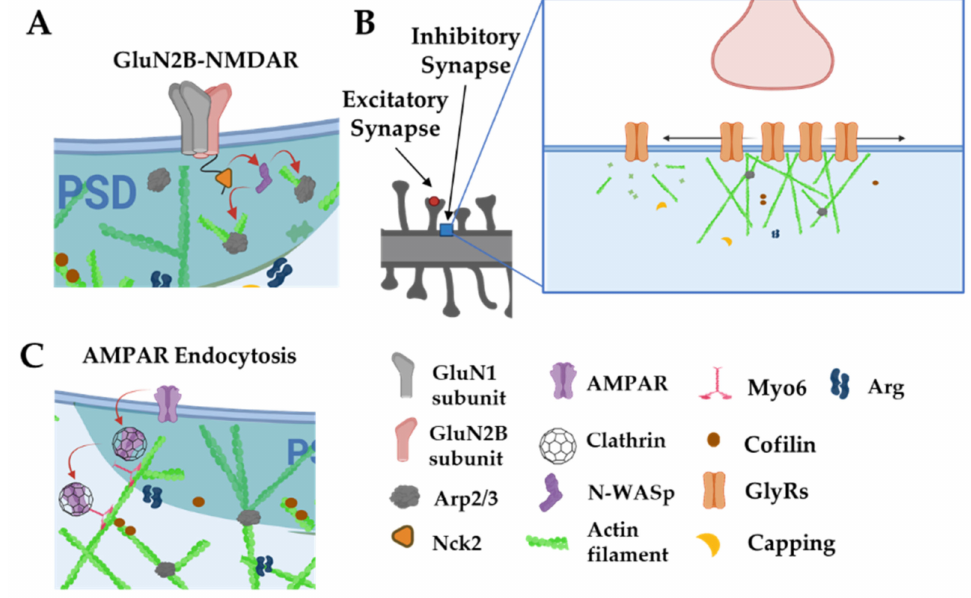
Figure 7. Actin is involved in postsynaptic receptor localization and trafficking. ( A ): The intracellular tails of GluN2B subunits interact with Nck2 to stimulate actin nucleation via N-WASp and the Arp2/3 complex. ( B ): Actin filaments anchor and space out glycine receptors. Disruption of actin filaments leads to smaller, denser clusters of glycine receptors and increases their diffusion out of synaptic zones. ( C ): Myo6 traffics AMPARs away from the PSD through actin filaments. Adapted from “Axonal-dendritic synaptic cleft, Dendritic spine, Post-synaptic membrane and Pre-synaptic membrane”, by https://BioRender.com (accessed on 26 January 2022) (2020). Created and retrieved from https://app.biorender.com/biorender-templates (accessed on 26 January